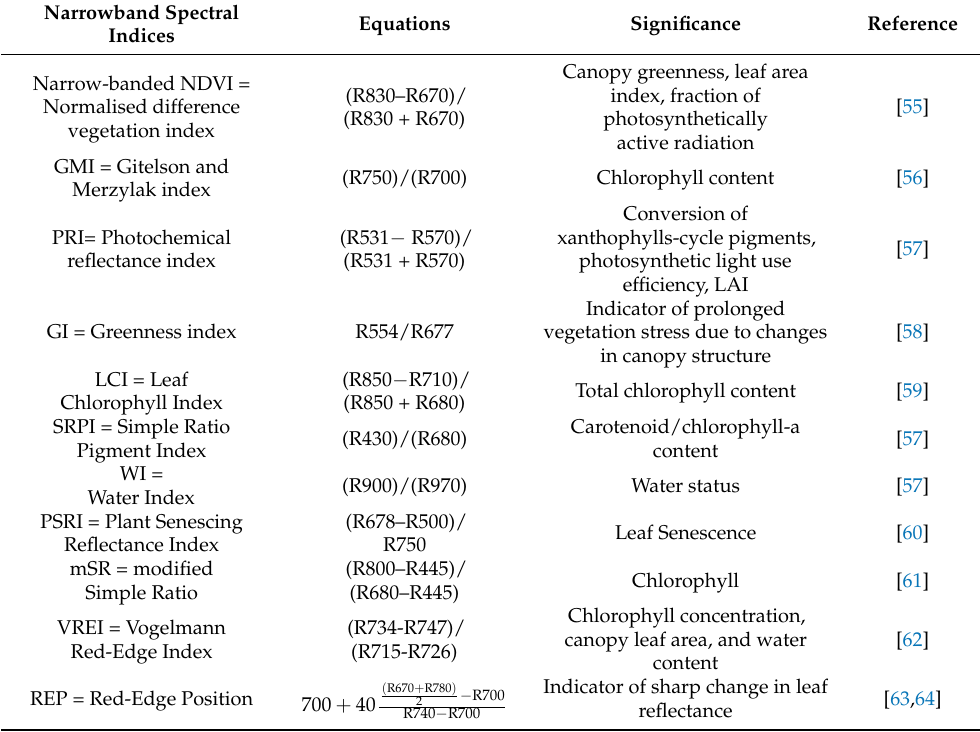
Table 2. Summary of different hyperspectral indices derived in the current